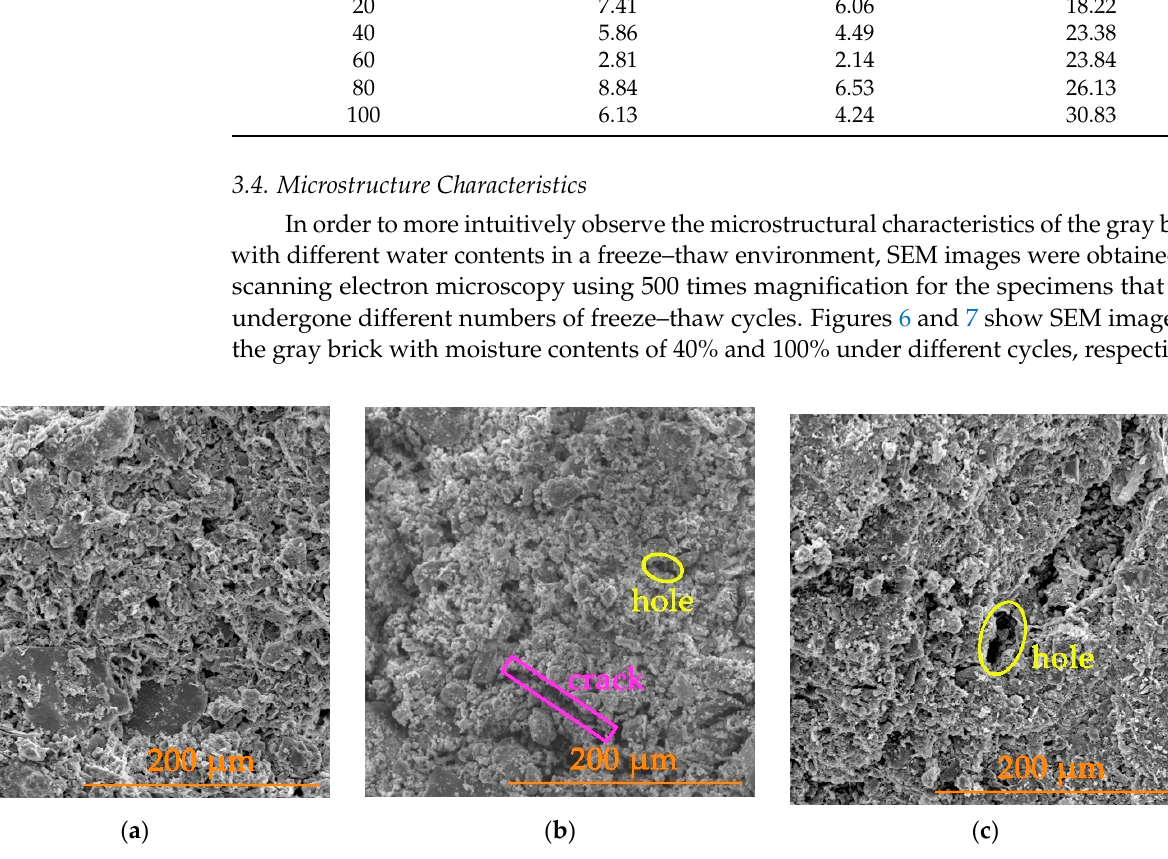
Figure 6. SEM images of a gray brick with a moisture content of 40% under different cycles: ( a ) the